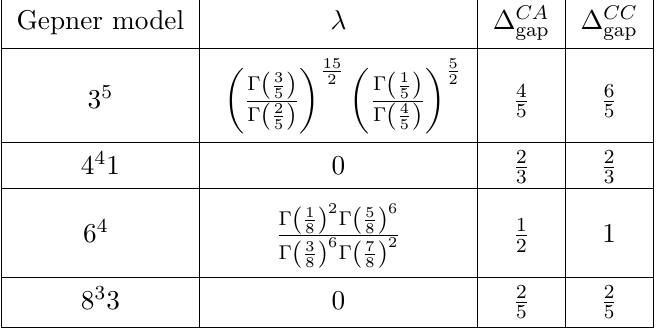
Table 5. CA and CC gaps in c = 9 Gepner